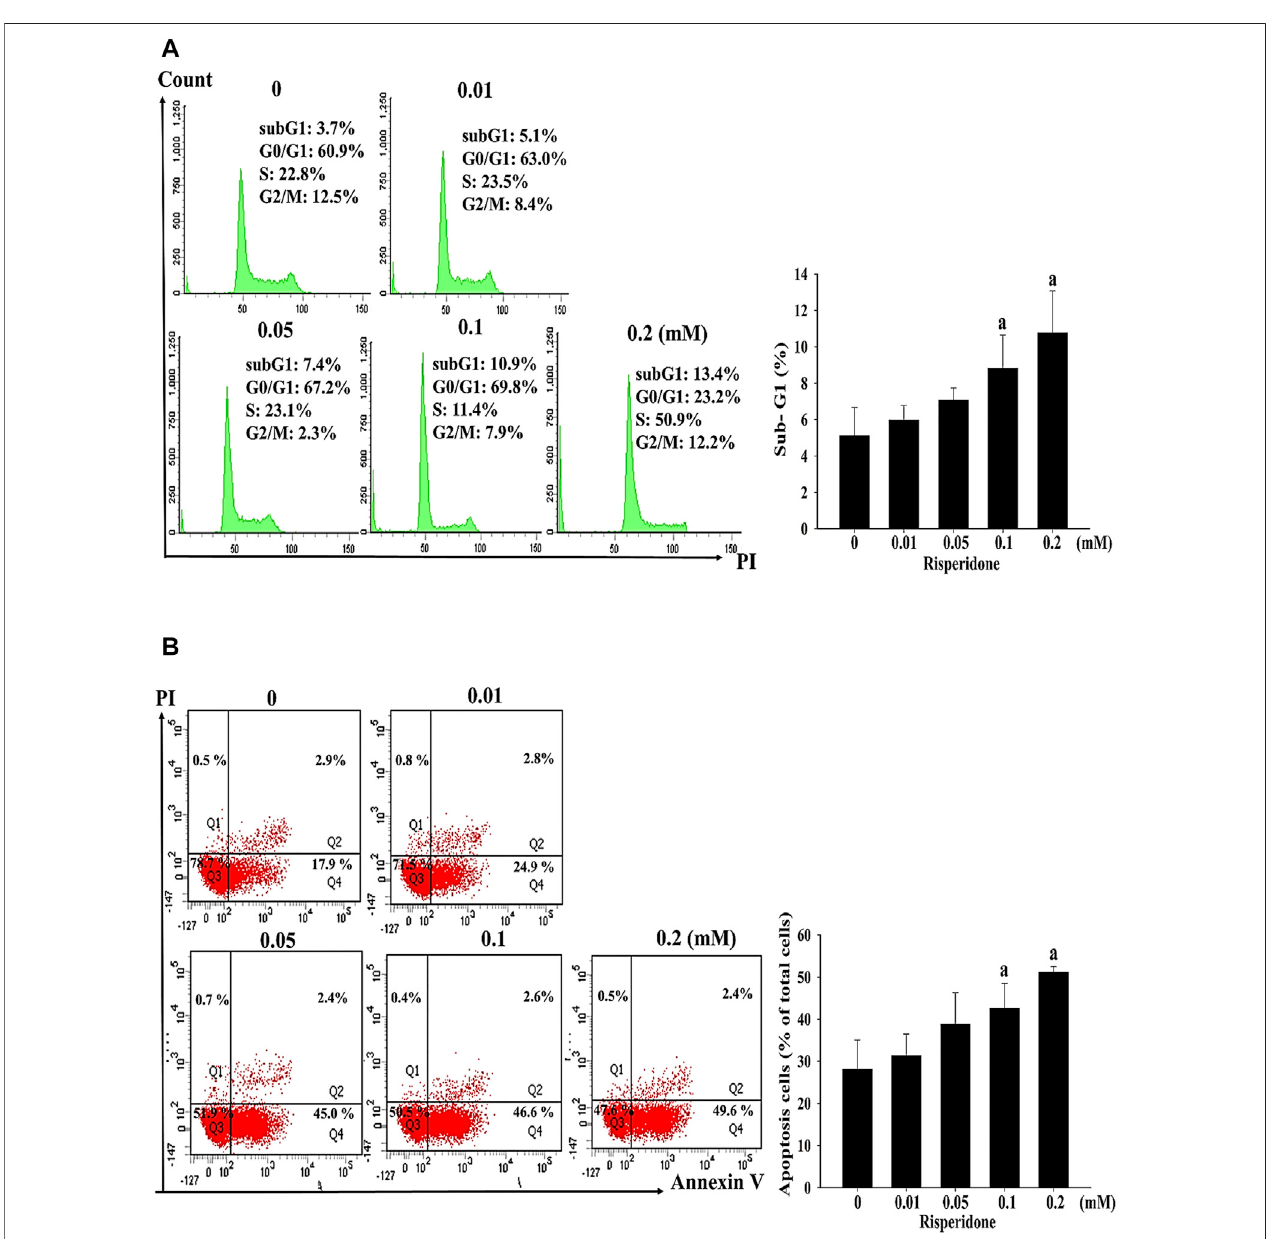
FIGURE 2 | Risperidone increases sub-G1 proportion and apoptosis in KATO-III cells. KATO-III cells were treated with different concentrations of risperidone for 24 h. (A) Representative histogram results of fl ow cytometry analysis. Bar diagram showing the percentage of sub-G1 proportion. (B) Representative results ofAnnexin V. Bar diagram showing the percentage of apoptotic cells. Three-repeated tests were completed. The letter a indicates a signi fi cant difference ( p < 0.05) compared with control (0 mM).